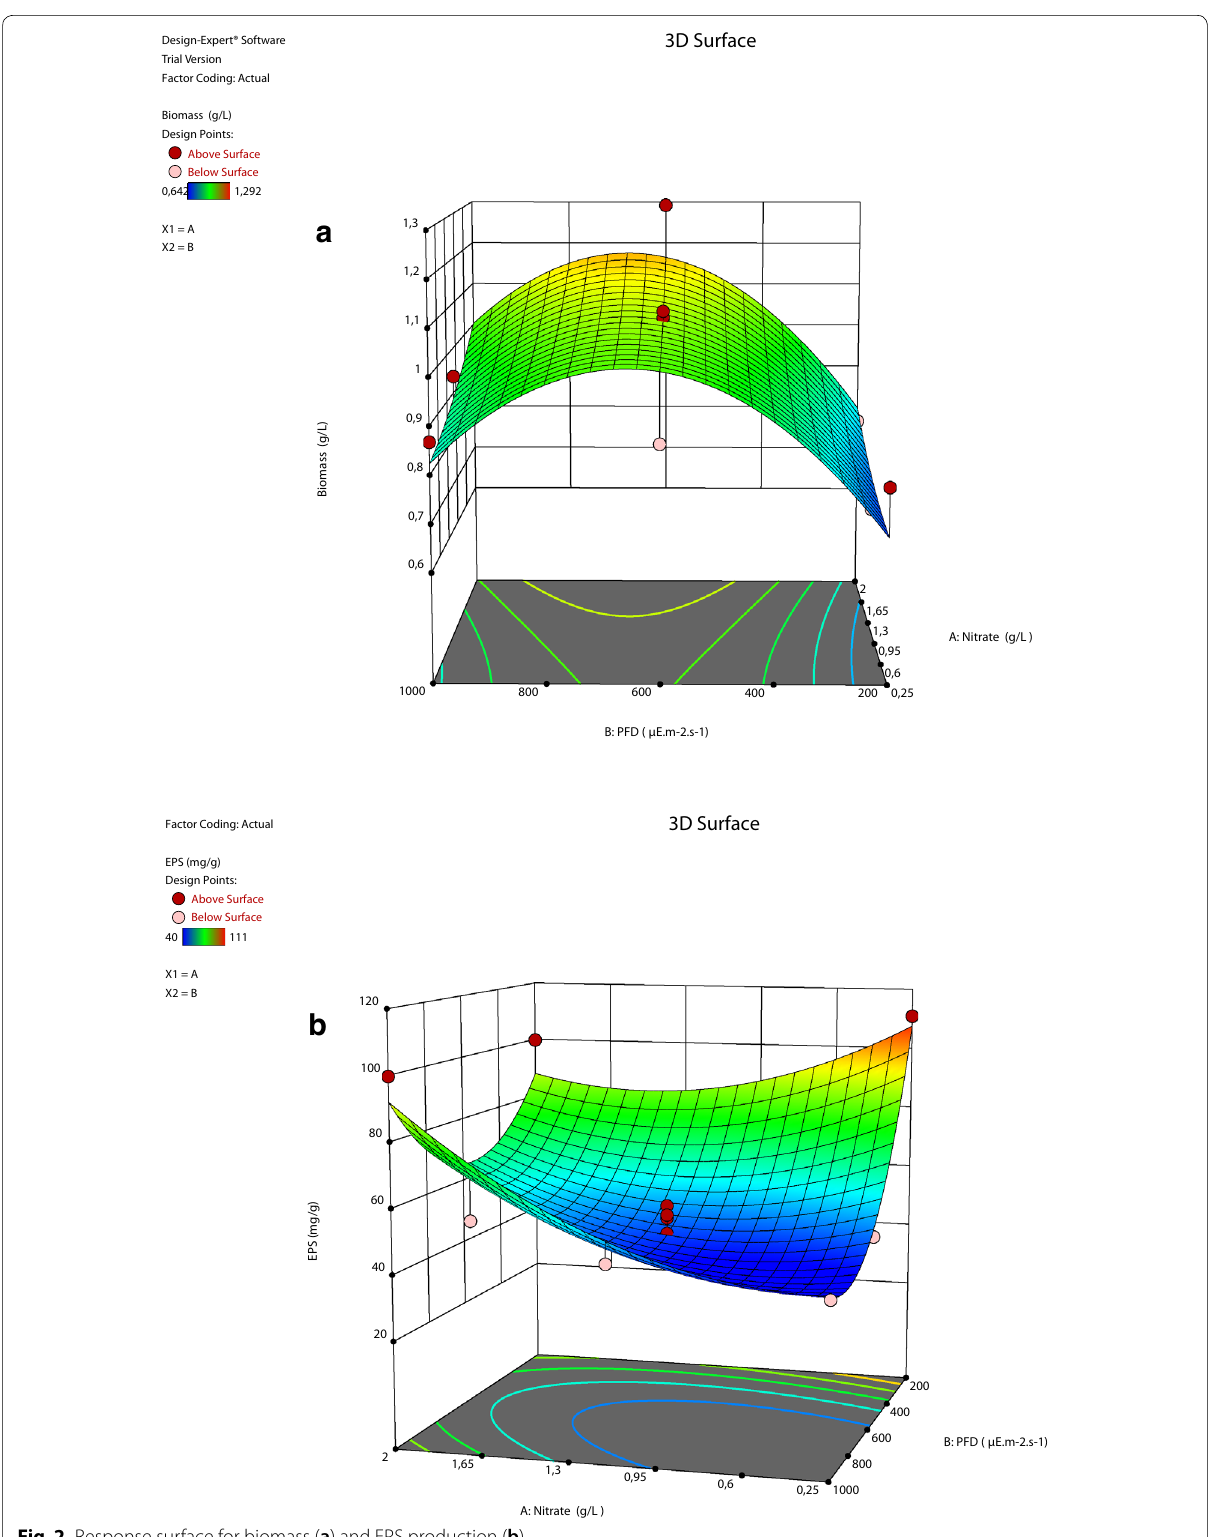
Fig. 2 Response surface for biomass ( a ) and EPS production ( b